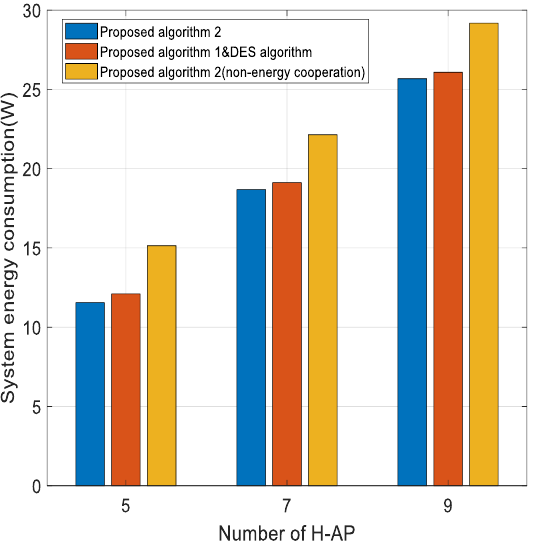
Figure 7. The performance of the proposed algorithm with different collection threshold.